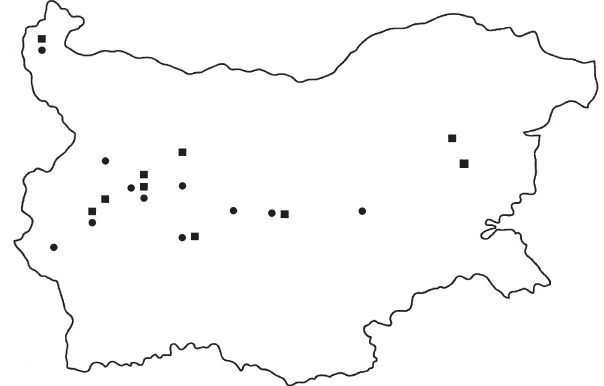
Fig. 1. - Map of Bulgaria with the place of origin of animals infected with Trichinella spiralis ( ■ ) or Trichinella britovi ( ● ) which were the source of infection for humans between 1995 to 2002.